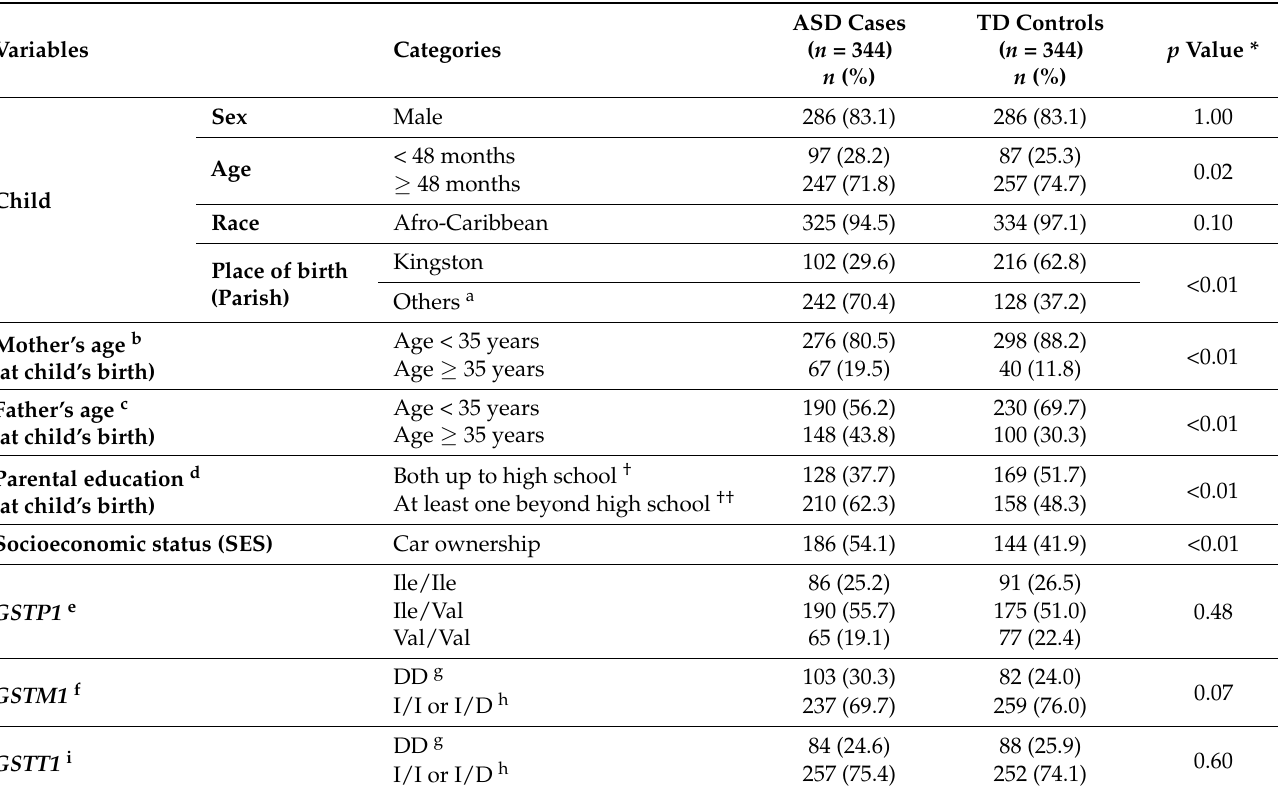
Table 1. Comparison of ASD and TD control groups with respect to characteristics of children and their parents (344 matched